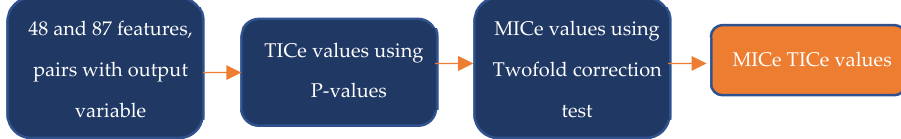
Figure 2. Procedures for finding MICe TICe values.